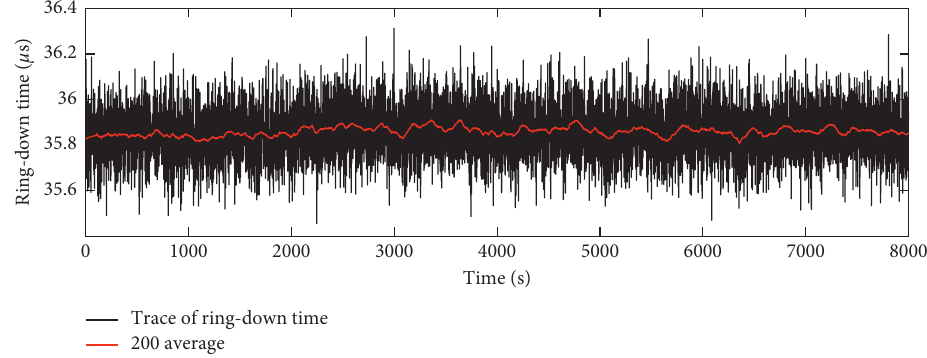
Figure 5: The 8000 sets of cavity ring-down time with N